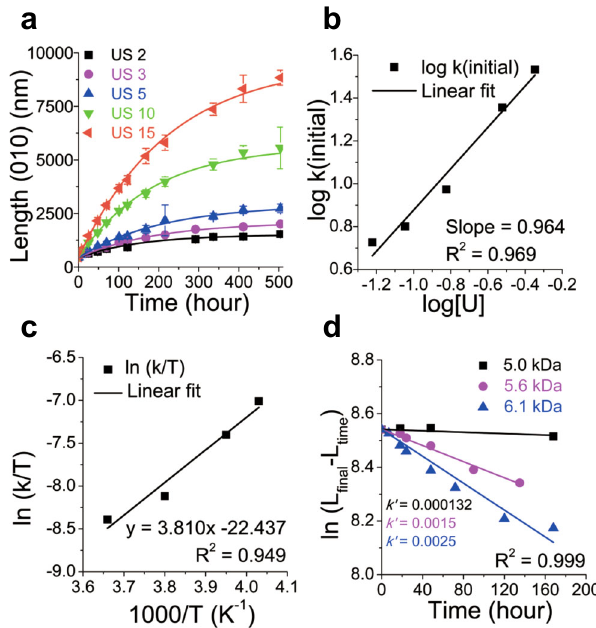
Fig. 4 Growth kinetic studies on living 2D CDSA. Plots showing a Lengths ( L n ) of 2D rectangles over time with various U/S ratios from 2 to 15 (monitored for 3 weeks). Error bars indicate standard deviations ( σ ). b initial reaction rates versus unimer concentration, [U], to con fi rm fi rst-order kinetics. c Eyring plot for the rate constants, k ’ , extracted from seeded- growth experiments at varying temperatures. d Plot of ln ( L fi nal – L (time)) versus time from the fi rst-order growth of various unimers with different DPs at 25°C.